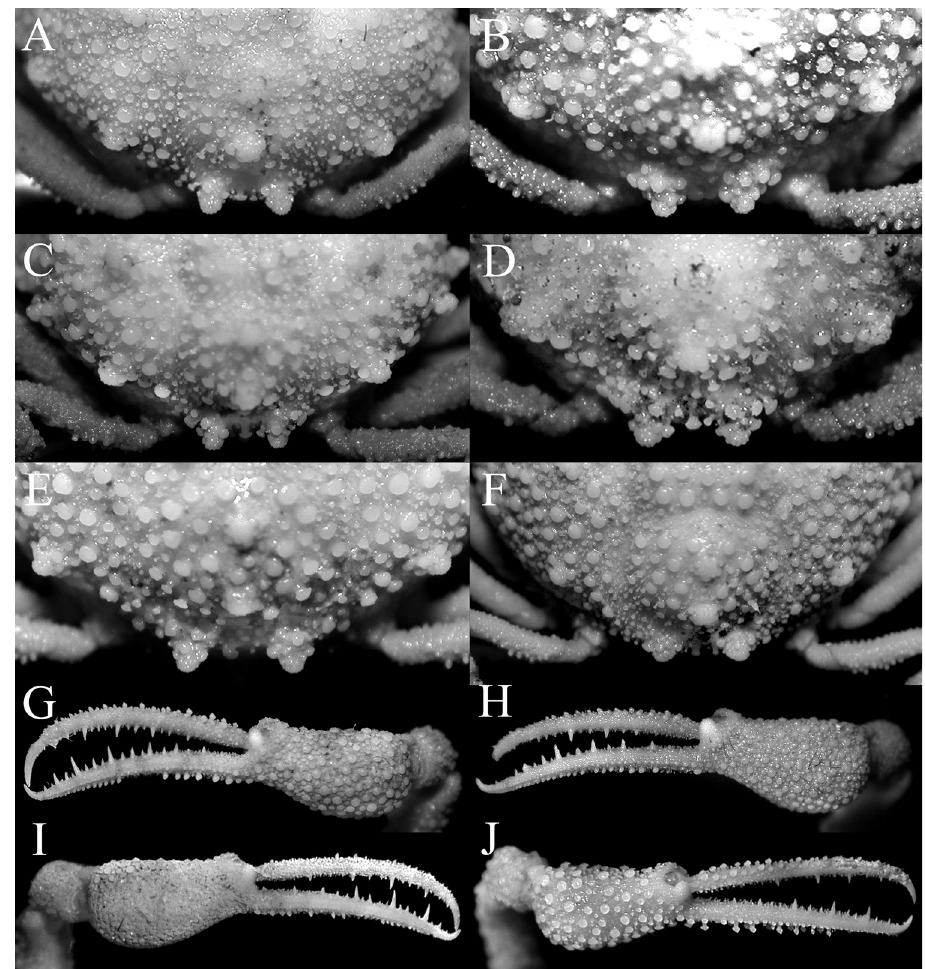
Figure 6. Pariphiculus agariciferus Ihle, 1918. A male (11.9 × 12.1 mm) (ZRC 2009.471), Vanuatu B male (15.8 × 15.0 mm) (ZRC 2017.187), Philippines C, J male (15.5 × 14.4 mm) (ZRC 2012.484), Philippines D male (12.8 × 13.7 mm) (ZRC 2017.186), Philippines E, G female (19.0 × 19.0 mm) (ZRC 2017.186), Philippines F, H female (22.1 × 21.3 mm) (ZRC 2009.288), Philippines I male (11.9 × 12.1 mm) (ZRC 2009.471), Vanuatu. A–F intestinal region and posterior margin of carapace G, H outer view of left chela I , J outer view of right chela. × 15.4 mm, 18.5 × 18.7 mm) (ZRC 2013.104), Maribojoc Bay, Panglao, Bohol, Philip- pines, coll. J. Arbasto, November 2003–April 2004. Vanuatu : 1 male (10.2 × 9.6 mm), 1 female (13.0 × 13.5 mm) (ZRC 2009.470), station AT13, south of Aésé Island, Pali- kulu Bay, 15 ° 27.8S 167 ° 15.7E, 146–153 m, Santo, coll. N.O.”Alis”, SANTO Expedi- tion, 19 September 2006; 1 male (11.9 × 12.1 mm) (ZRC 2009.471), station AT61, south of Urélapa Island, West Malo Island, 15°39'S 167°01'E, 266–281 m, Santo, coll. N.O.”Alis”, SANTO Expedition, 4 October 2006; 2 juvenile females (10.3 × 9.4 mm, 13.4 × 13.6 mm), 1 carapace only (17.9 × 17.4 mm) (ZRC 2009.472), station